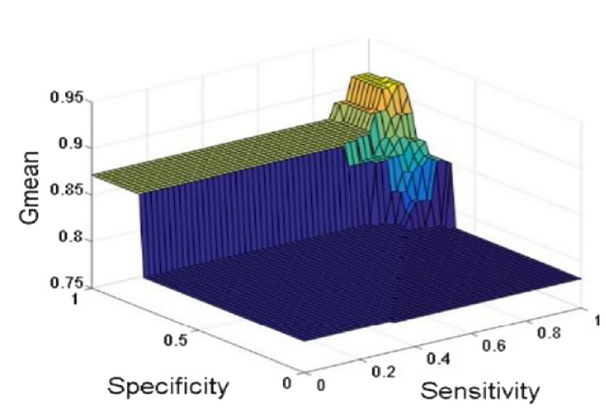
Figure 18: Sensitivity versus specificity versus Gmean